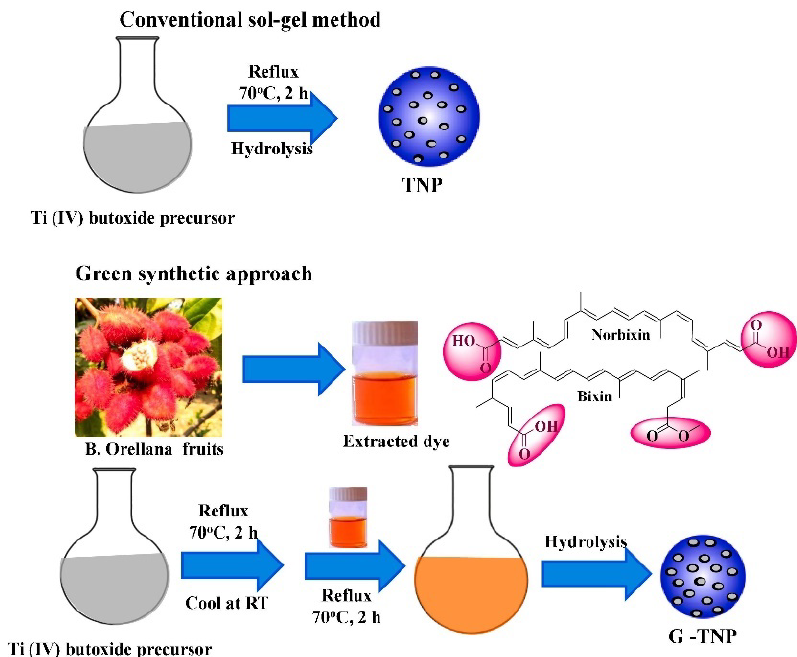
Figure 10. Simplified schematic of the production process of TiO 2 nanoparticles using the sol–gel method without and with using a bio-capping agent. Reprinted from [30].